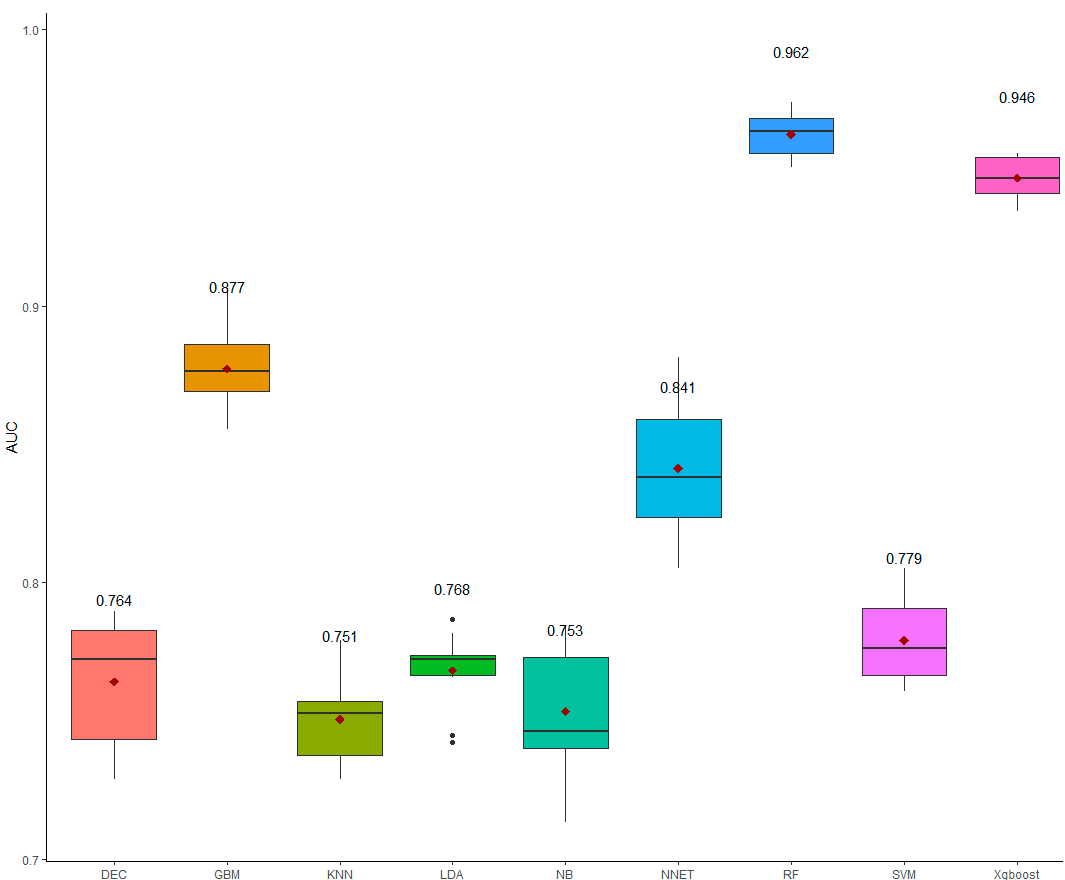
Figure 3. The boxplot for the area under the ROC curve (AUC) for the nine machine learning algorithms*. The values indicated the mean of AUC obtained from tenfold cross-validation. * Decision tree (DEC), gradient boosting (GBM), K-nearest neighbors (KNN), linear discriminant analysis (LDA), naive bayes (NB), artificial neural networks (NNET), random forest (RF), linear support vector machines (SVM), and extreme gradient boosting (Xgboost). The red diamond shapes indicated the mean of AUC; the black dots indicated the outliners.